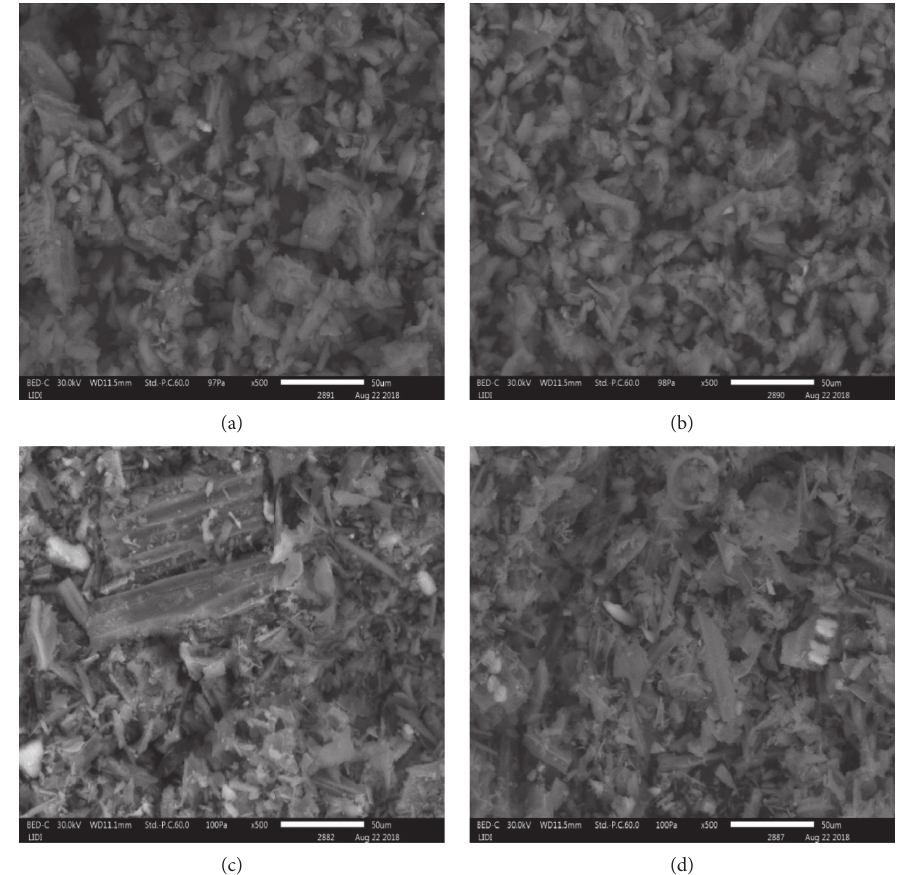
Figure 3: The SEM for activated carbon of (a) before adsorption for corncob and (b) after adsorption for corncob; (c) before adsorption for sorghum husk and (d) after adsorption for sorghum